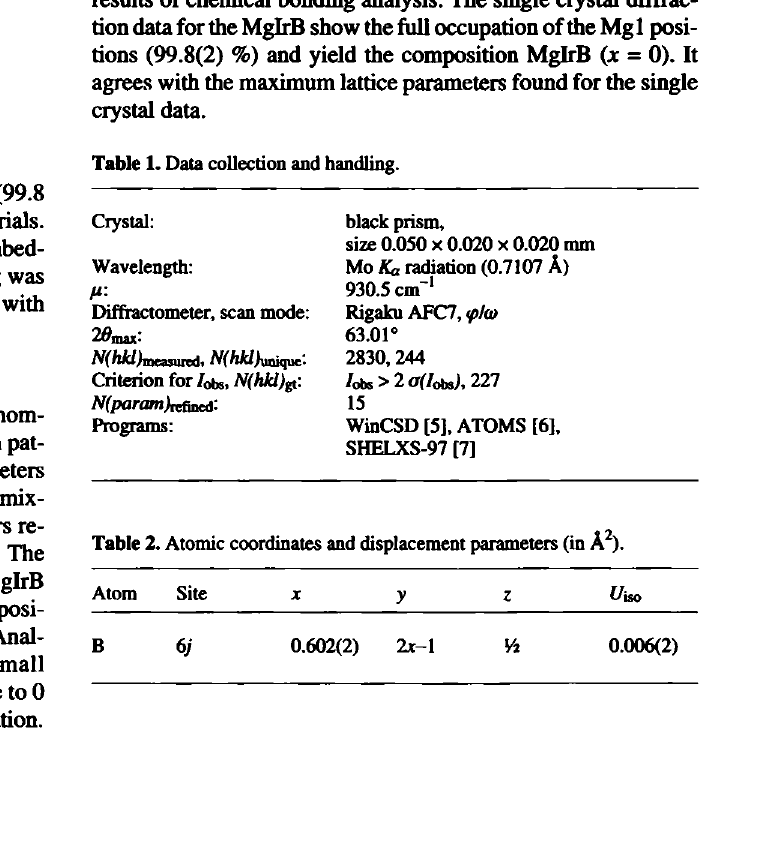
Table 1. Data collection and handling.